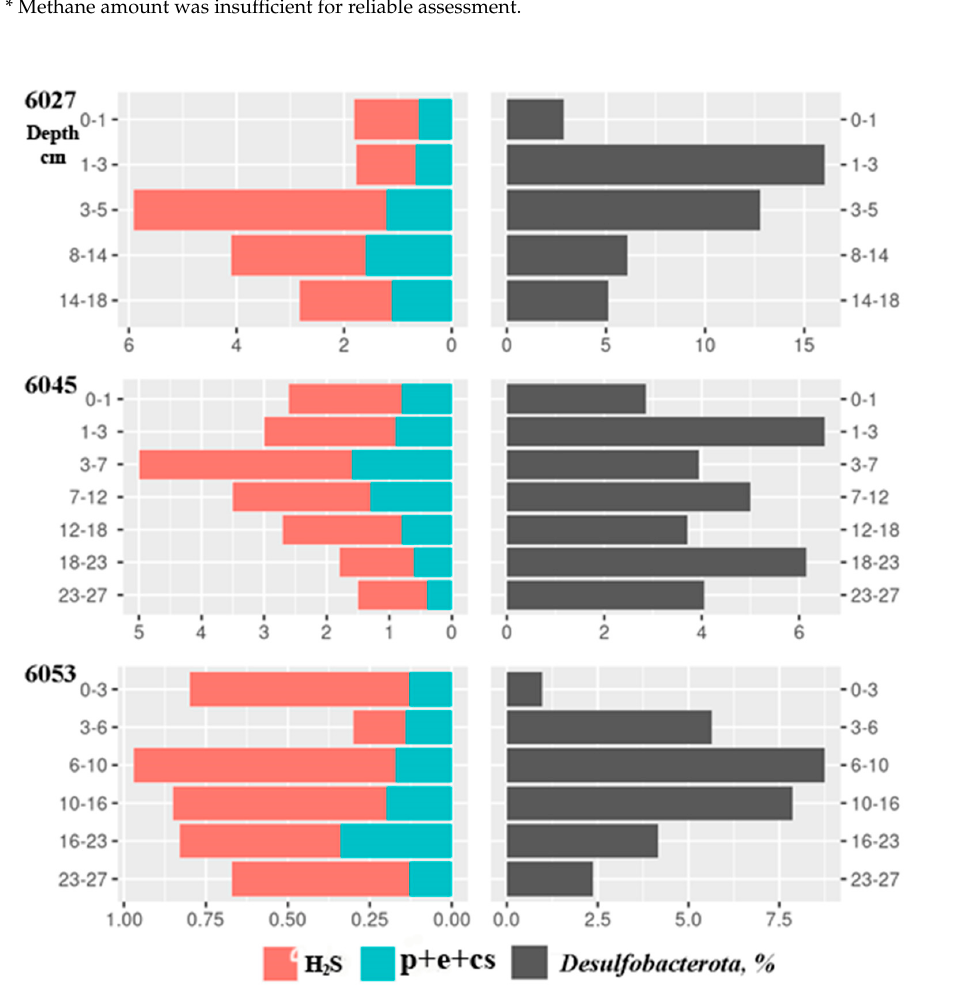
The carbon isotopic composition of organic matter (OM) was measured for the sedi- ments from all three stations. The spread of the values for different horizons varied within 2–3‰ (Table 3). The average values, however, revealed that the lightest OM carbon( δ 13 C org = − 29.6‰) was present in the sediments of the active seep (st. 6045). The heaviest OM carbon isotopic composition was found in the sediments of the background station 6053 ( δ 13 C org = − 26.7‰).